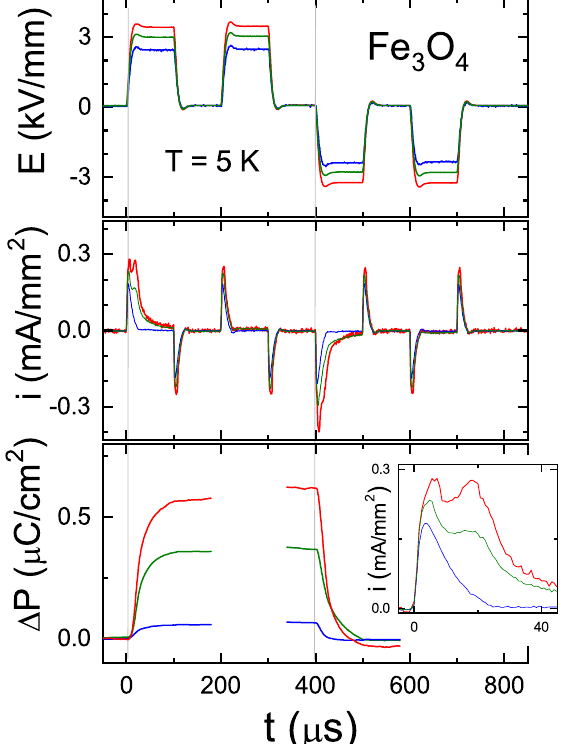
Figure 3. PUND (positive-up-negative-down) characterization of the sample. Top: Applied voltage pulses as a function of time, with three different maximum voltages. Middle: Current-response to the applied voltage. Change in the polarization obtained by integrating the switching part of the current response. The inset shows a magnification of the current response during